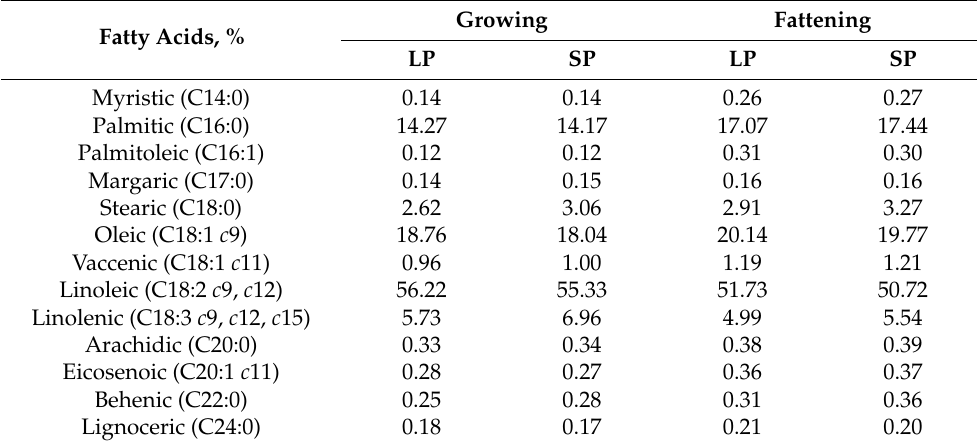
Table 1. Fatty acid composition (% of total fatty acids) of the two-phase experimental diets (growing and fattening), differing in crude protein content (standard, SP vs. low, LP). Fatty Acids,